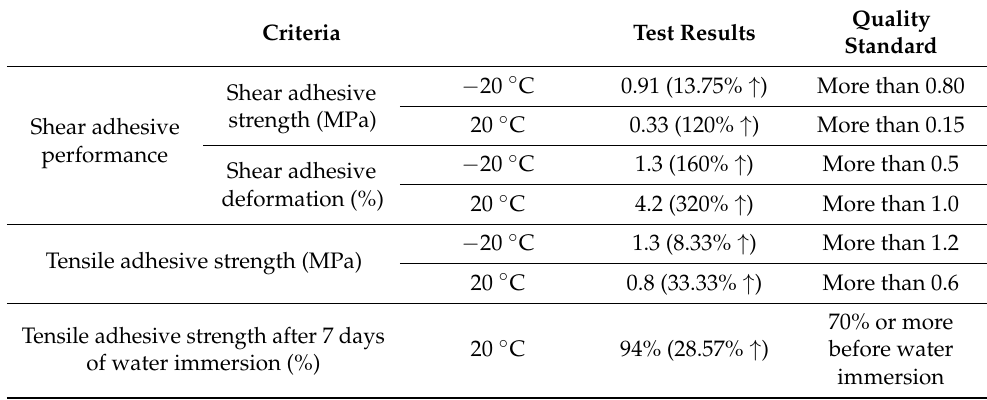
Table 9. Performance test results of waterproofing sheet effect on LMC pavement